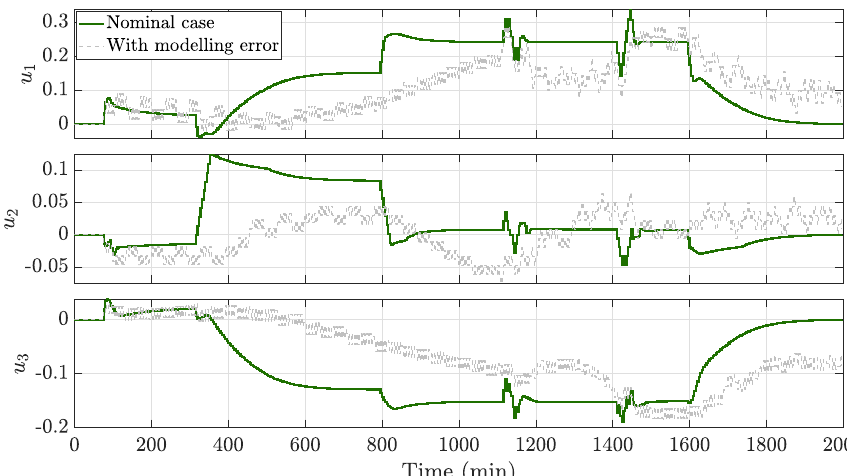
Figure 10. Case 1—Manipulated variables of the